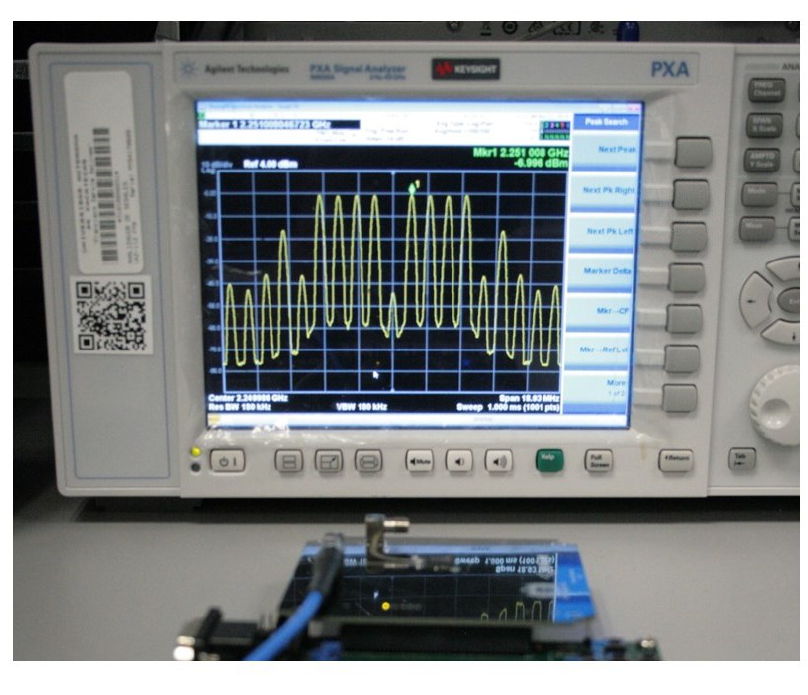
Figure 11. Signal analyzer, RABE and Zedboard on QPSK. The RABE prototype transmitting with 4-tone QPSK modulation, with 1 MHz frequency separations.